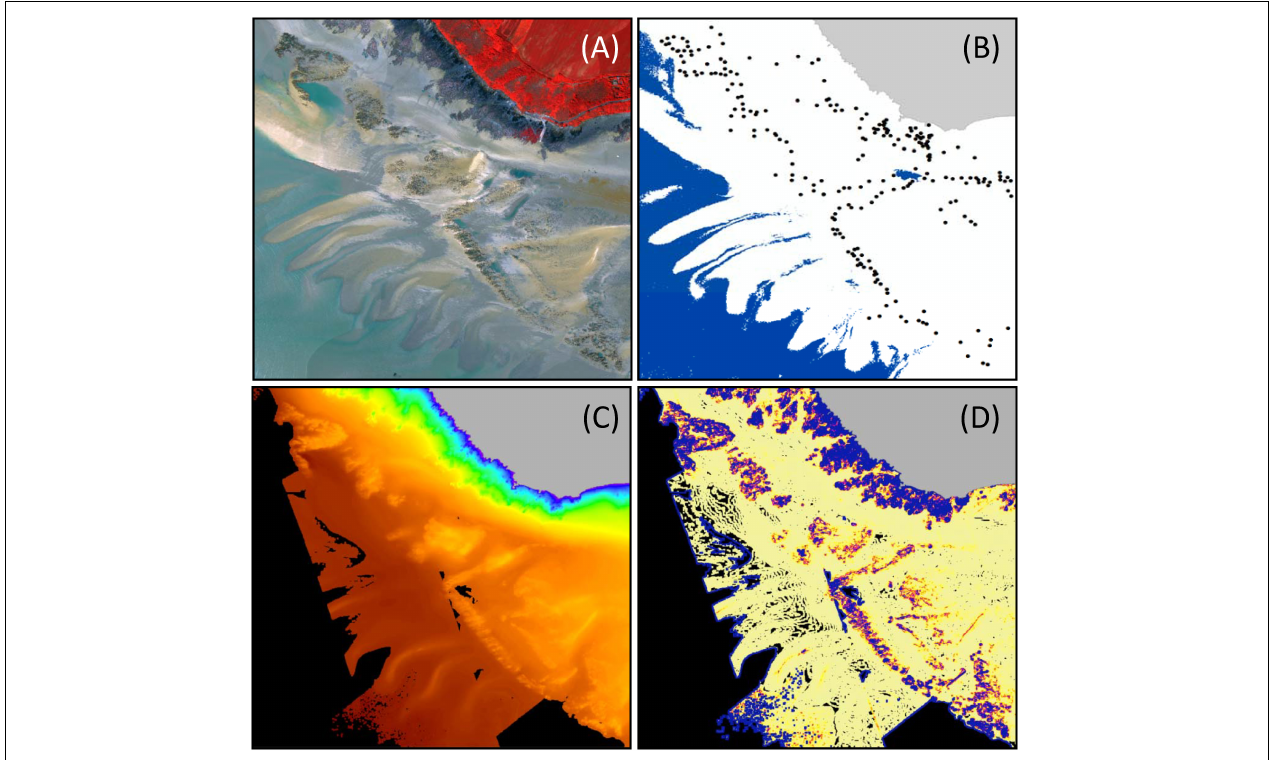
FIGURE 2 | Data acquired on Champeaux site. Hyperspectral (A) and field data (B) were specifically acquired for the present study. lidar bathymetry data (C) were provided by SHOM, the French hydrographic office and rugosity (D) was computed from bathymetry data.